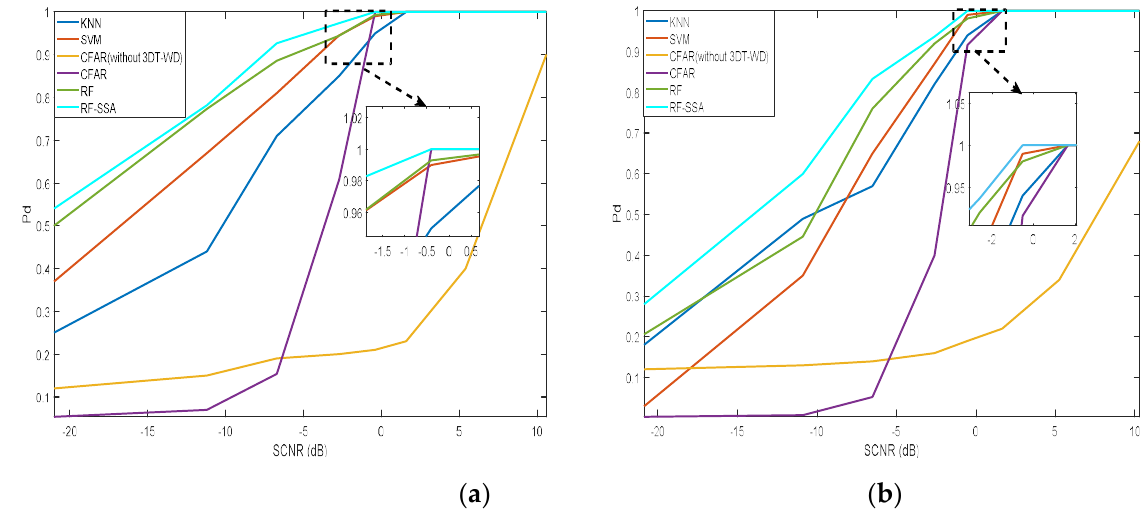
Figure 5. Detection performance comparisons of different detectors: ( a ) v = 0.1; ( b ) v = 0.5.